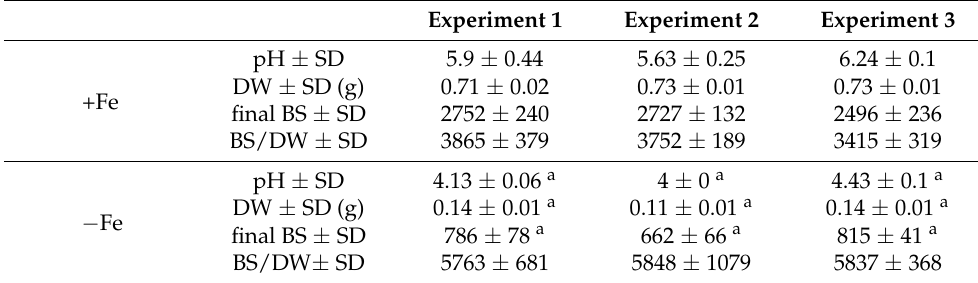
Figure 6. CGQ-mediated growth monitoring of A. fumigatus AfS77 cultured for 24 h at different days (experiments 1–3) under +Fe and − Fe conditions. Each experiment included biological triplicates. Details of the graph are as in the caption of Figure 2. Table 2. Comparison of DW, BS values, BS/DW ratios, and pH values of A. fumigatus AfS77 cultured for 24 h at different days under +Fe and − Fe conditions. Mean ± standard deviation of biological triplicates is displayed. Statistically significant differences (marked by a ) of − Fe compared to +Fe conditions were assessed by one-way ANOVA and Tukey’s multiple comparison